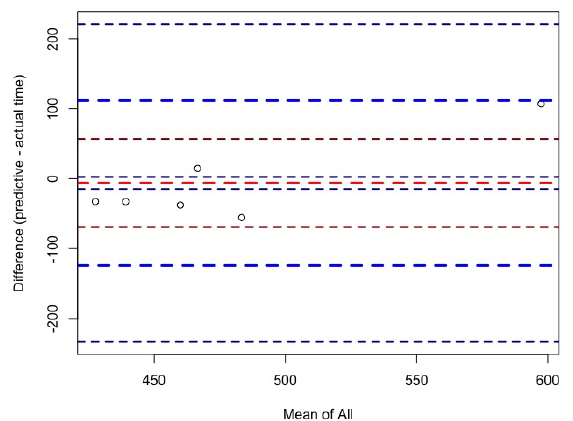
Figure 3. Bland–Altman plots comparing predicted and e ff ective race times for Figure 3 . Bland – Altman plots comparing predicted and effective race times for men.